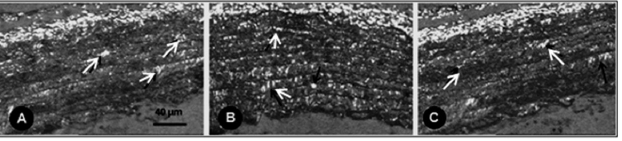
Figure 6. Cross-sections of rat aorta stained in Picrosirius and photo- graphed with crossed polarizing filters. The amount of collagen (ar- rows) is higher in the OC group (B) compared with the MA group (A) and it is lower in the OT group (C) compared with the OC group (B).